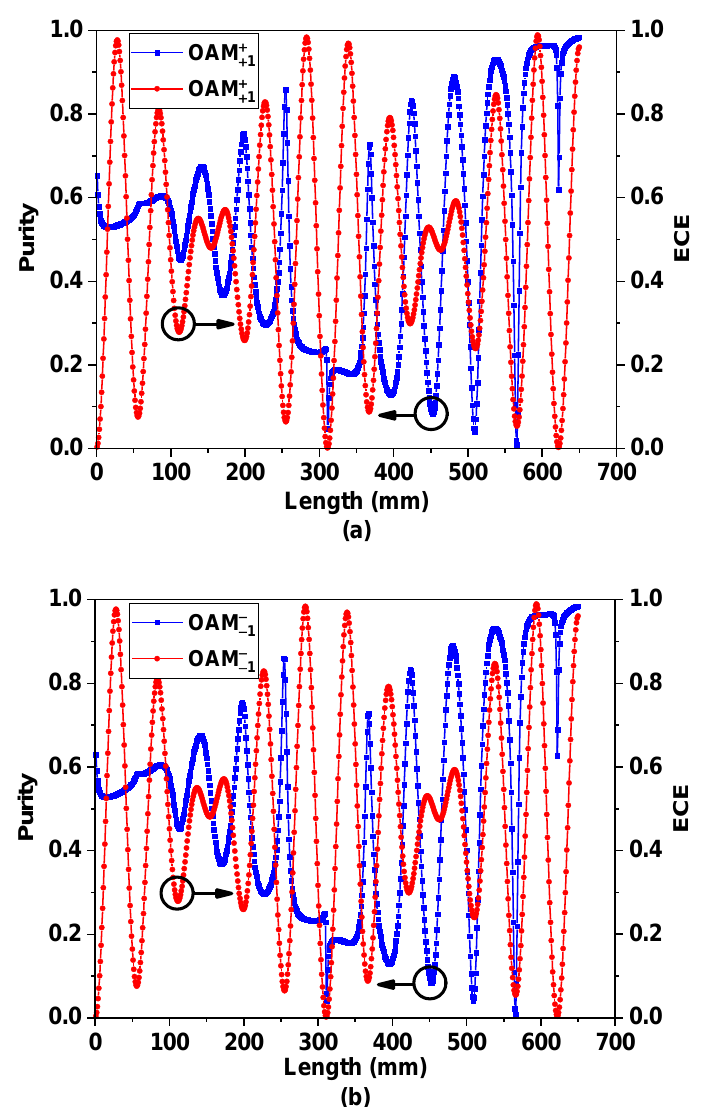
Figure 5. ( a ) Purity and energy conversion efficiency (ECE) of +1 order OAM mode with LPFM input. ( b ) Purity and energy conversion efficiency (ECE) of -1 order OAM mode with LPFM input.